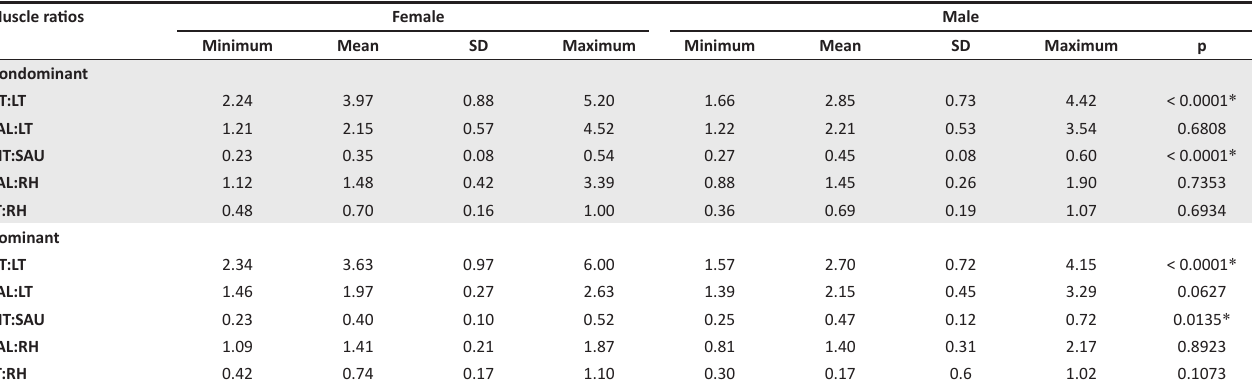
TABLE 3: A comparison between the force couple ratio measurements in male ( n = 29) and female participants ( n = 29) ( n = 58). Muscle ratios Female Nondominant